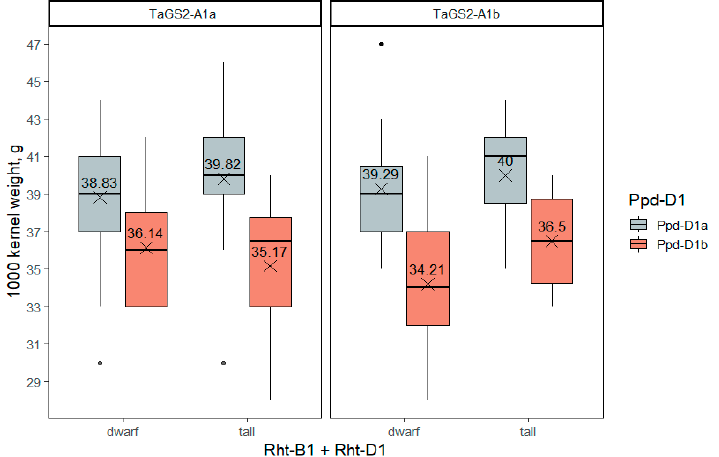
Figure 7. The 1000-kernel weight in wheat accessions differing in Rht-1 , Ppd-D1 and TaGS2-A1 genotypes. The dots indicate outliers.